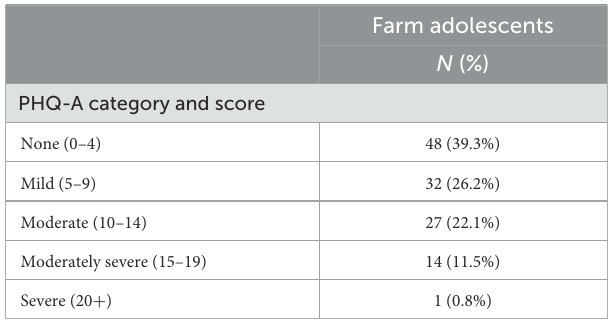
TABLE 4 Prevalence of symptoms of depression among farm adolescents ( N = 122).